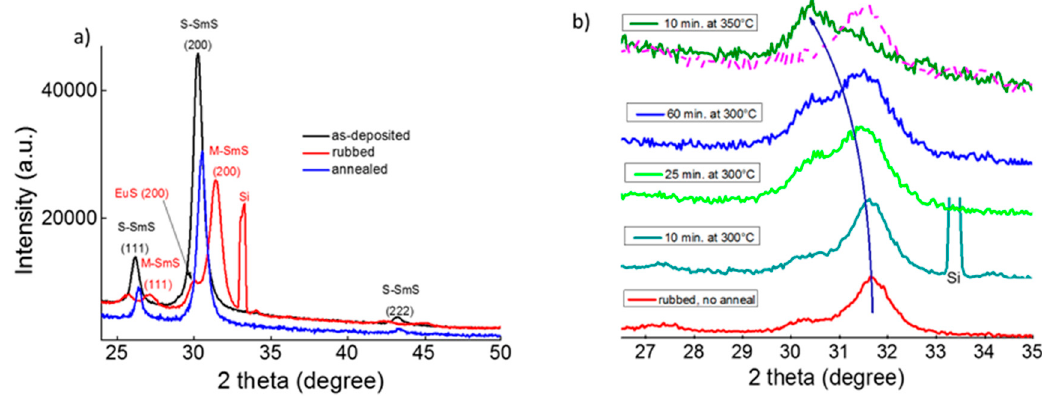
Figure 5. ( a ) XRD of an as-deposited SmS / EuS / SmS (35 / 30 / 35 nm) tri-layer at 400 ◦ C (black curve), after rubbing (red curve) and after annealing in vacuum at 400 ◦ C, for 10 min, and then cooling down (blue curve). ( b ) Cumulative annealing in ambient air of a similarly rubbed sample, as in ( a ), to provide the thermally triggered metal to semiconductor transition. For comparison, XRD pattern of a 100 nm SmS thin film, after 30 min annealing at 350 ◦ C, is also depicted with the purple dashed line.